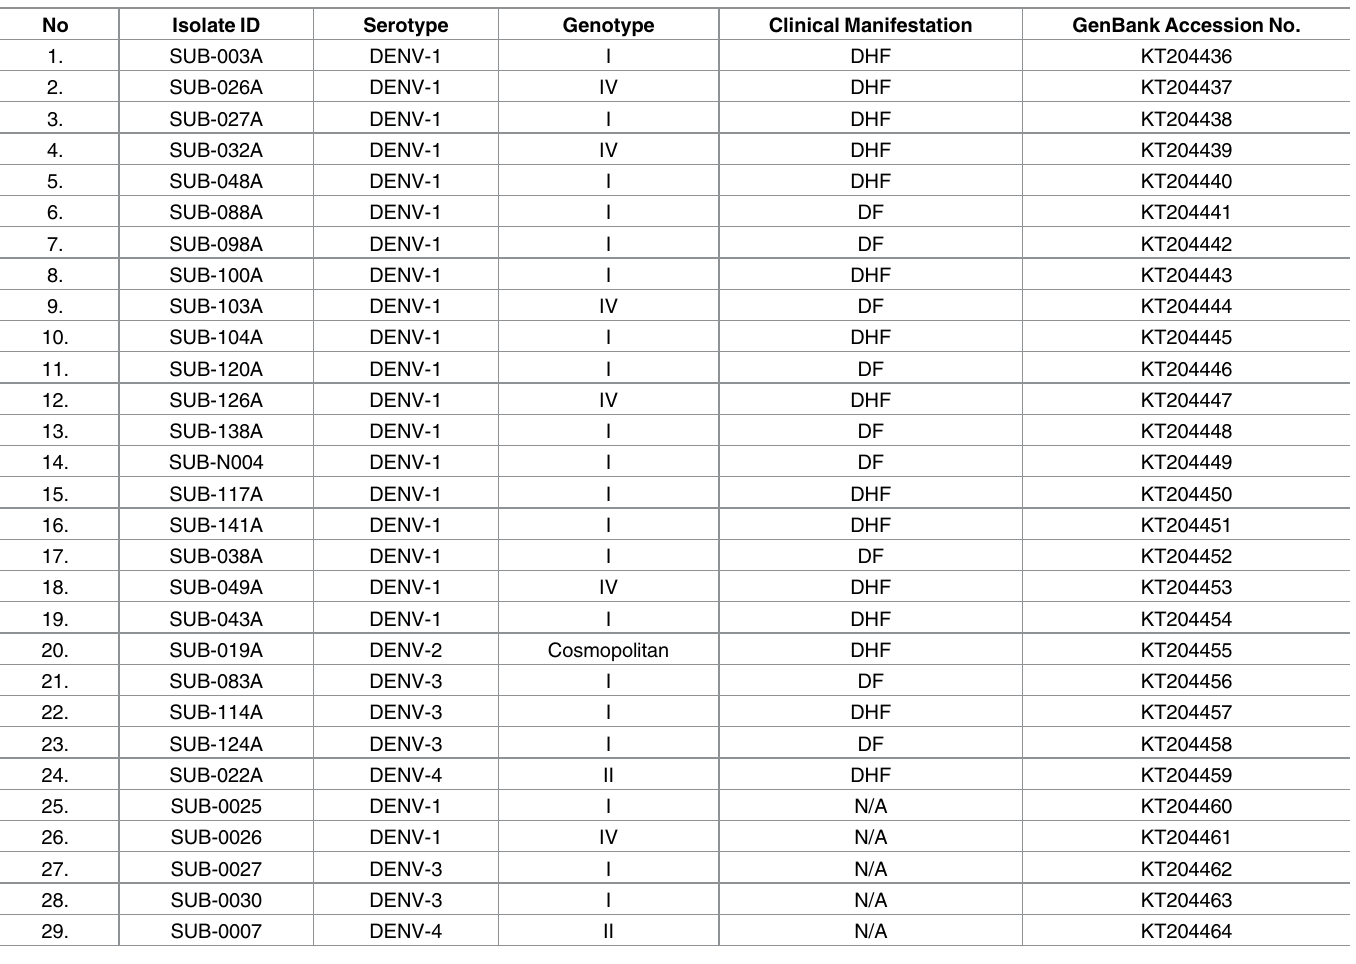
Table 5. Surabaya DENV isolates with their Envelope genes